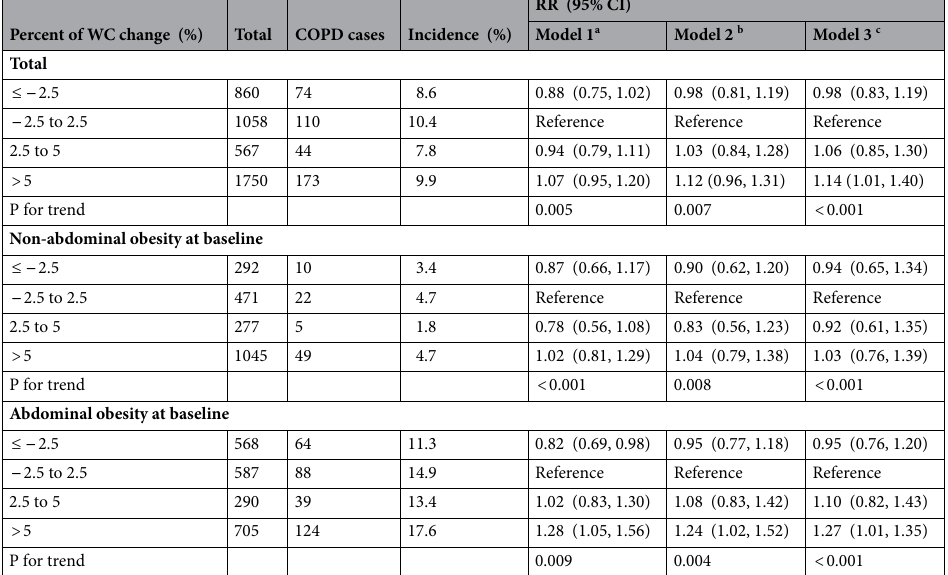
Table 3. Risk of chronic obstructive pulmonary disease (COPD) by percentage of waist circumference (WC) change for women. Data are relative risk (RR) and 95%CIs. a Adjusted for age at baseline. b Adjusted for variables in model 1 as well as education level, smoking status, alcohol drinking, and physical activity at baseline. c Adjusted for variables in model 2 as well as body mass index, systolic blood pressure, diastolic blood pressure, fasting plasma glucose, total cholesterol, triglycerides, high density lipoprotein cholesterol, forced expiratory volume in one second and forced vital capacity at